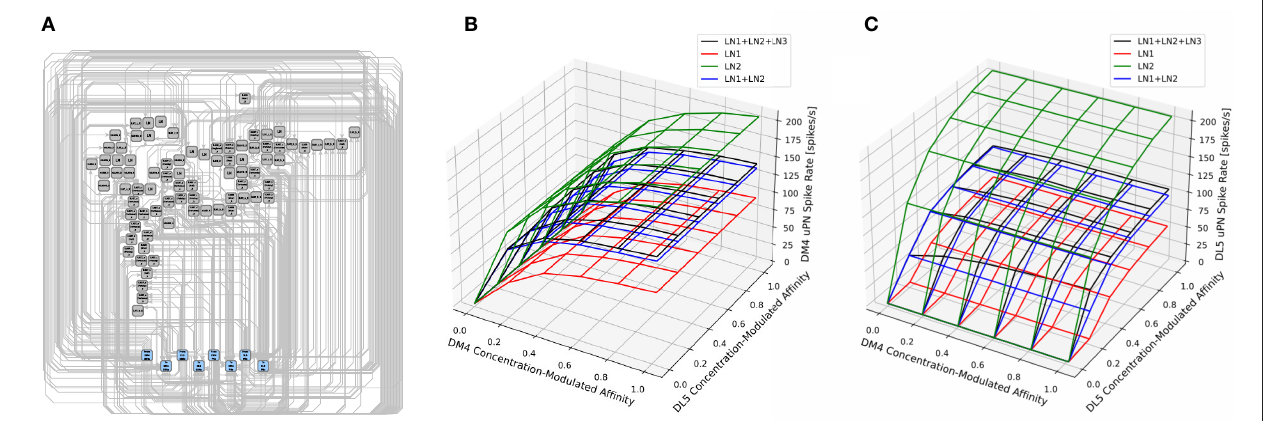
FIGURE 10 | Characterization of DM4 PN and DL5 PN responses of a circuit consisting of interconnected DM4 and DL5 glomeruli. (A) A circuit diagram of the interconnected DM4 and DL5 glomeruli. Toward the bottom, the blue nodes represent ports to and from DM4/DL5 OSNs/PNs. Each gray node corresponds to a specific LN in the Hemibrain dataset. Only connectivity between the gray nodes and the blue nodes are shown in the diagram. (B) DM4 PN steady-state firing rate and (C) DL5 PN steady-state firing rate as glomeruli are subject to different concentration modulated affinity values. For both (B,C) : (red) Only LN1 feedback motifs are present. (green) Only LN2 feedback motifs are present. (blue) LN1 and LN2 feedback motifs are present. (black) LN1, LN2 and LN3 feedback motifs are